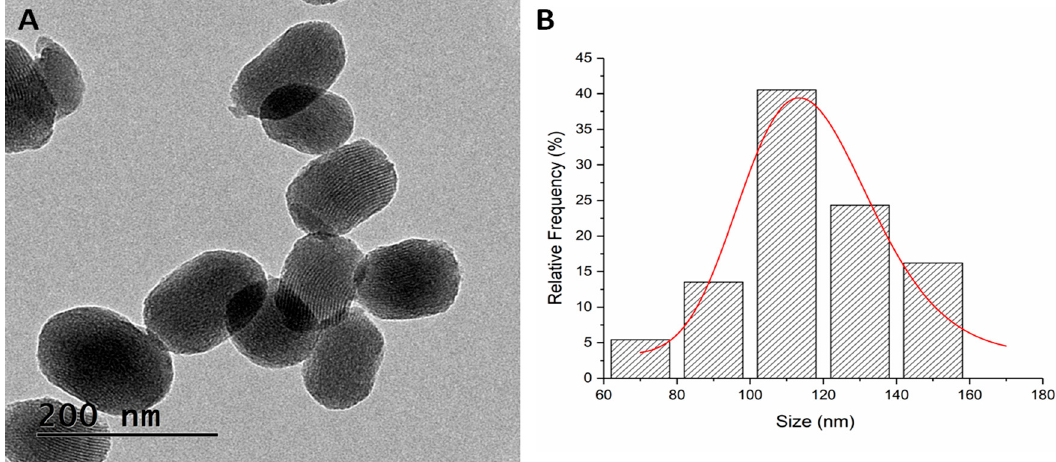
Figure 4. TEM micrograph of MSN-AP-AF-Sn ( A ) and mean size distribution ( B ).